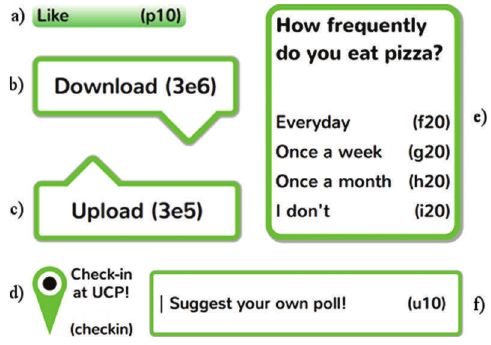
Figure 1: Default graphical representations for widgets.